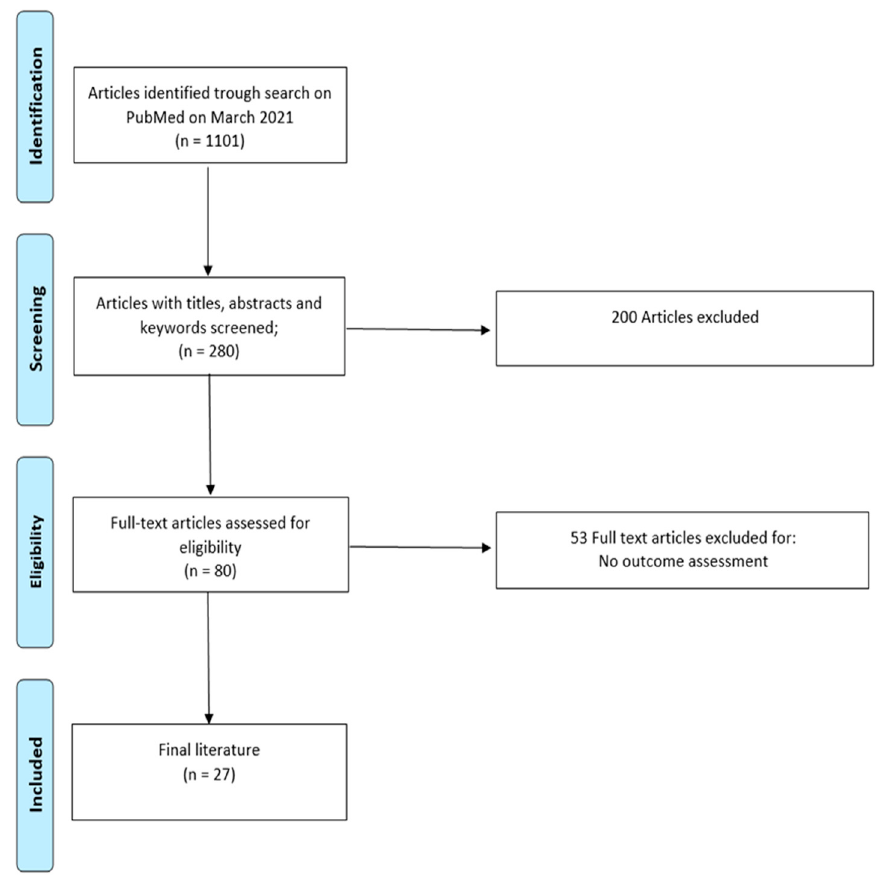
Figure 1. Flowchart outlining the protocol adopted in this systematic review for literature selection.